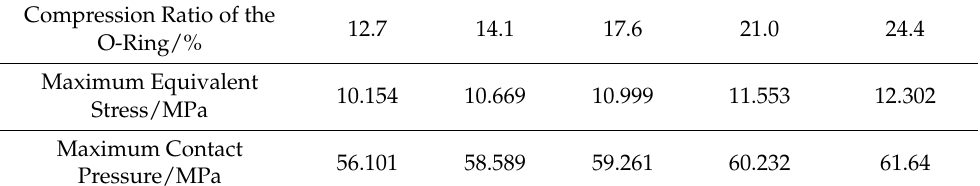
Table 4. Maximum equivalent stress and maximum contact pressure for different compression ratios.